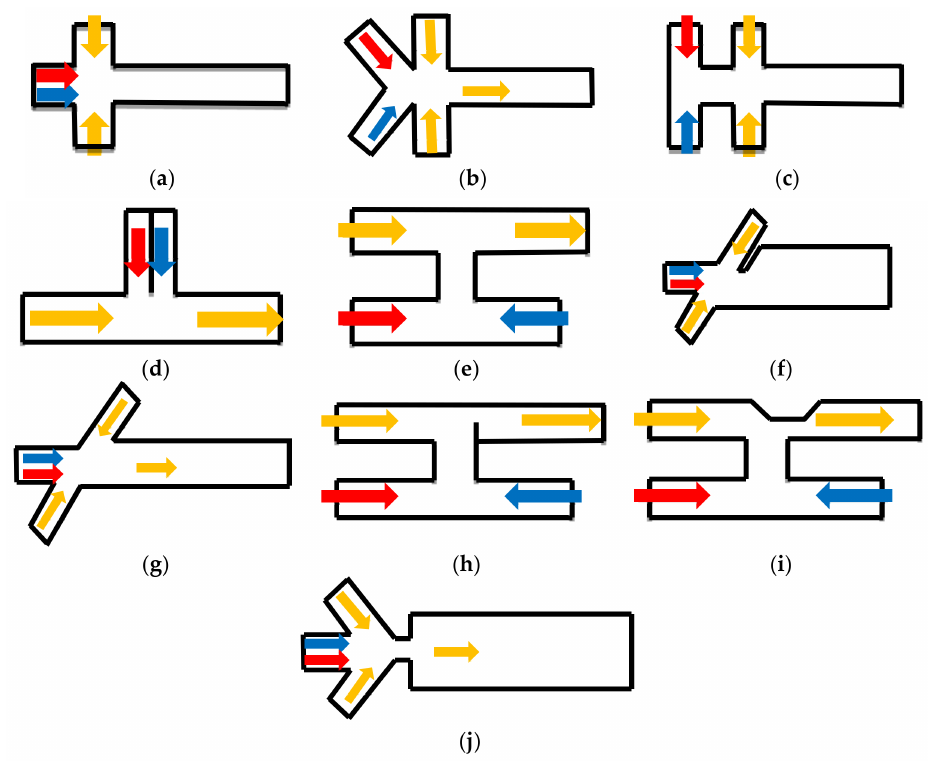
Figure 3. The schematic figures of the different generation sections. ( a – c ), three types of the asymmetric inlets model. ( d – i ), six types of the “convergent–divergent” model